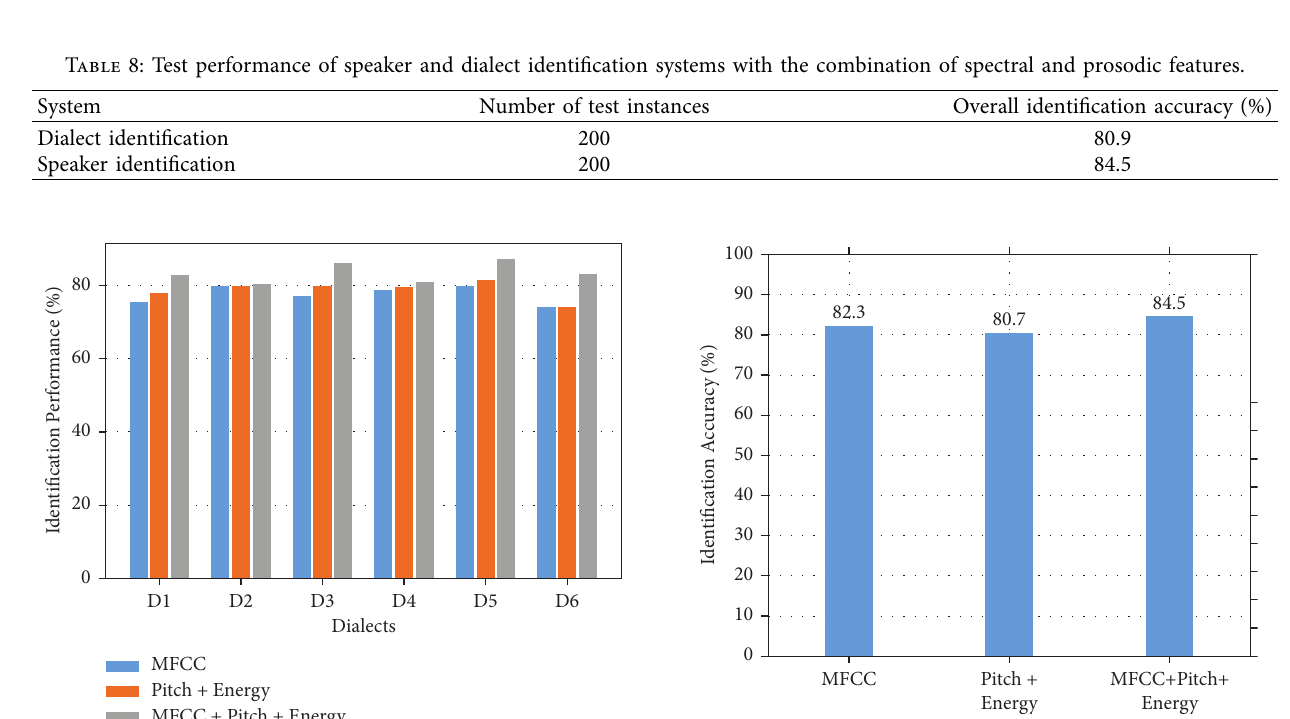
Figure 10: Identification performance of speaker identification system with a different set of